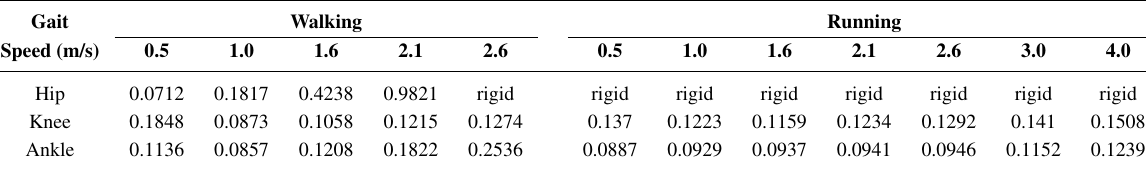
(Nm/(deg · kg)), for minimizing r